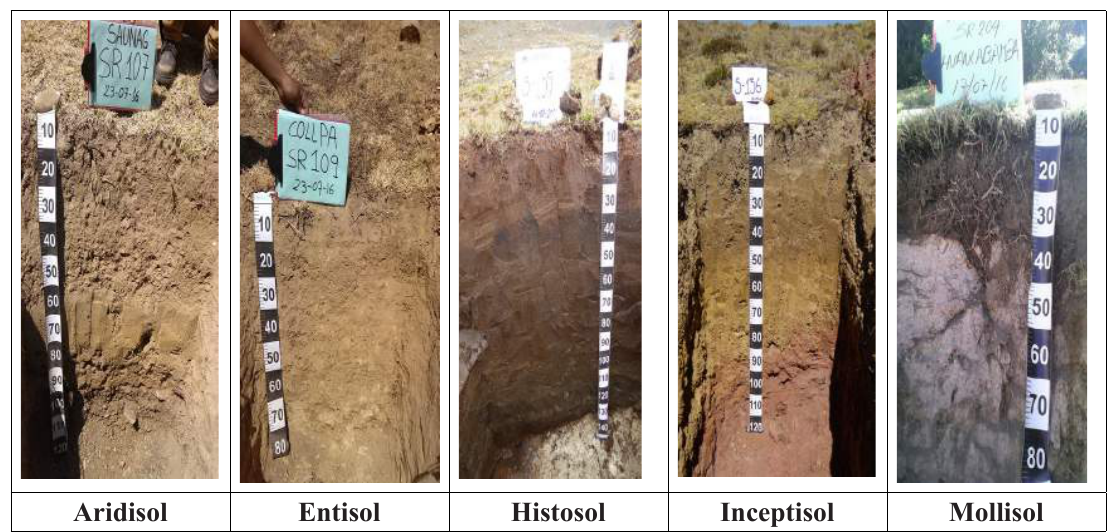
Figure 2: Soil orders in the San Rafael